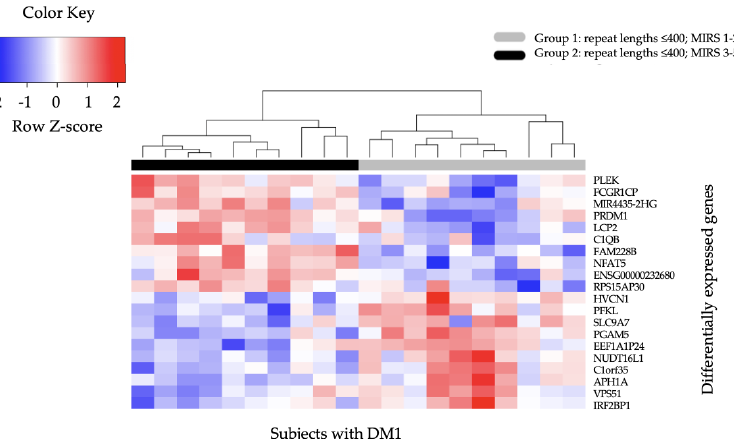
Figure 1. Hierarchical Clustering Heatmap of top 20 differentially expressed genes in DM1 OPTIMISTIC Group 1 and Group 2 patients. The heatmap presents the top 20 significant differentially expressed genes in subjects with DM1 from Group 2 (CTG repeat length ≤ 400, MIRS score 3–5) compared to Group 1 (CTG repeat length ≤ 400, MIRS score 1–2). Columns represent subjects with DM1, while rows represent specific genes of interest. The Z-score presents a measure of distance, in standard deviations, away from the mean. The color indicates the differentially expressed genes, with red indicating 10 higher expressed genes in Group 2 compared to Group 1 and with blue 10 lower expressed genes.